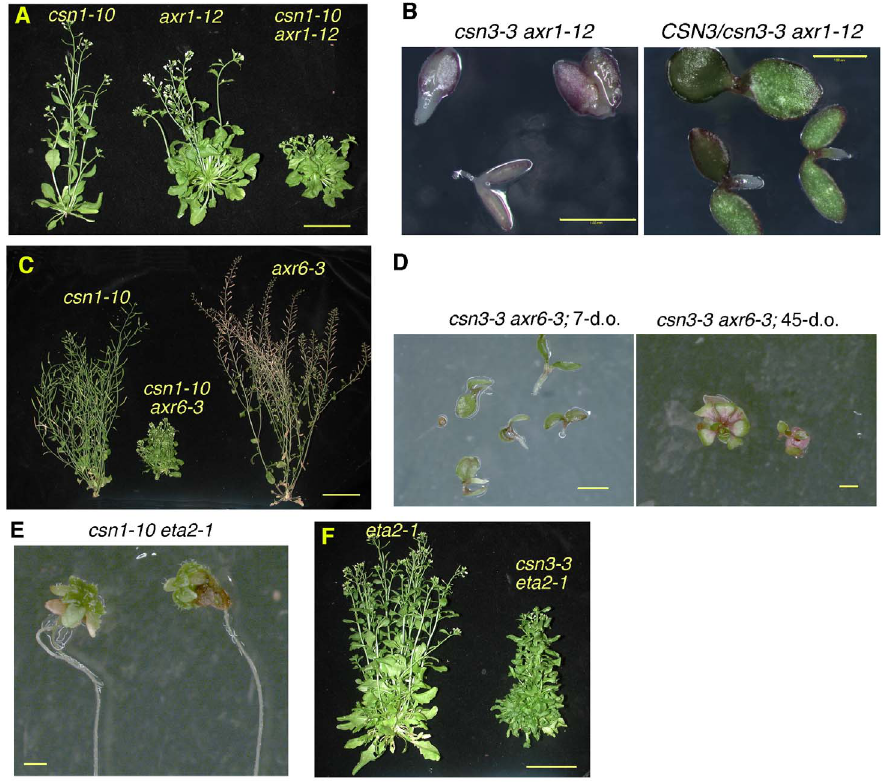
Figure 5. csn3-3 and csn1-10 exhibit distinct double mutant interactions. ( A ) Adult csn1-10 axr1-12 double mutant exhibit a slightly more severe dwarf phenotype than either of the single mutants. Size bar=4 cm. ( B ) csn3-3 interacts with axr1-12 synergistically, resulting in the seedling lethality. Right panel shows the seedling-lethal phenotype of heterozygous csn3-3/CSN3 in the axr1-12 background. Size bar=1 mm. ( C–D ) While csn1-10 axr6-3 plants are viable and complete the life cycle, csn3-3 interacts with axr6-3 synergistically, with double mutants exhibiting developmental arrest at the seedling stage. Size bars=4 cm ( C ) and 1 mm ( D ), respectively. ( E–F ) csn1-10 exhibits a stronger interaction with eta2-1 than does csn3-3 . As previously reported [43], csn1-10 eta2-1 seedlings fail to develop past the early seedling stage. Size bars=1 mm ( E ) and 4 cm ( F ), respectively.